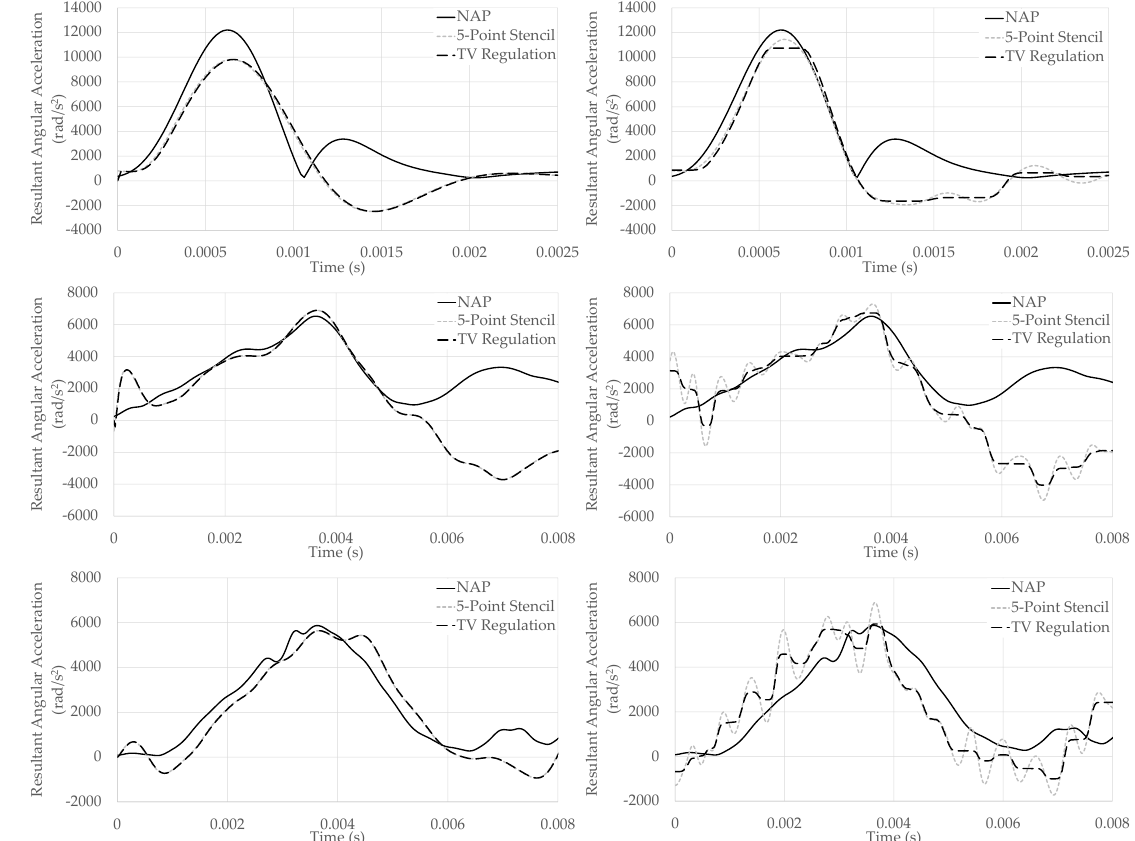
Figure 4. Angular acceleration as a function of time for rotational velocity data filtered at 1 kHz ( left ) and 2 kHz ( right ). Data from Softball ( top ), soccer ball ( middle ) and drop ( bottom ) impacts are